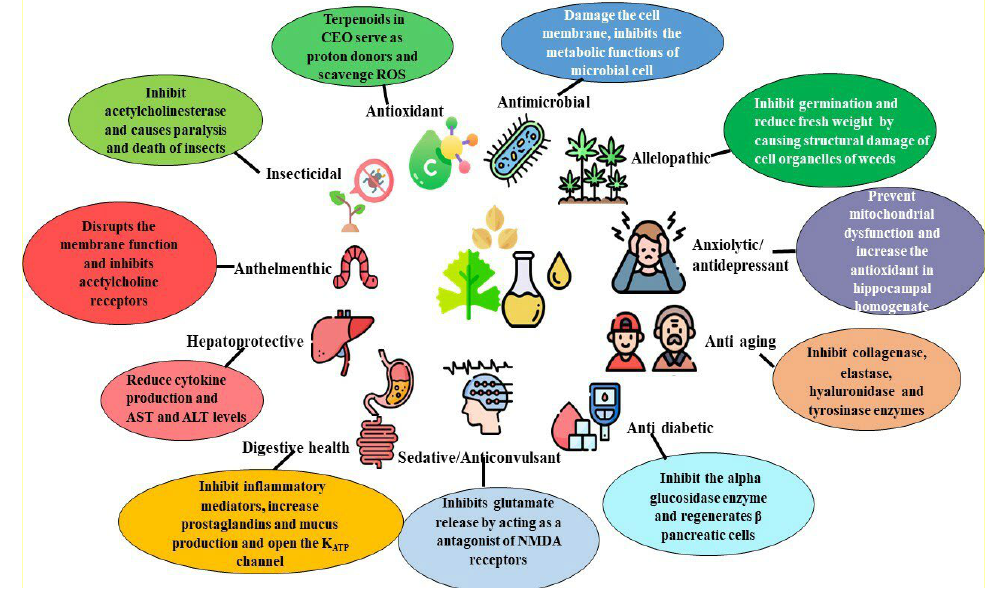
Figure 2. Biological properties of coriander essential oil. Table 6. Antioxidant profile of C. sativum seed